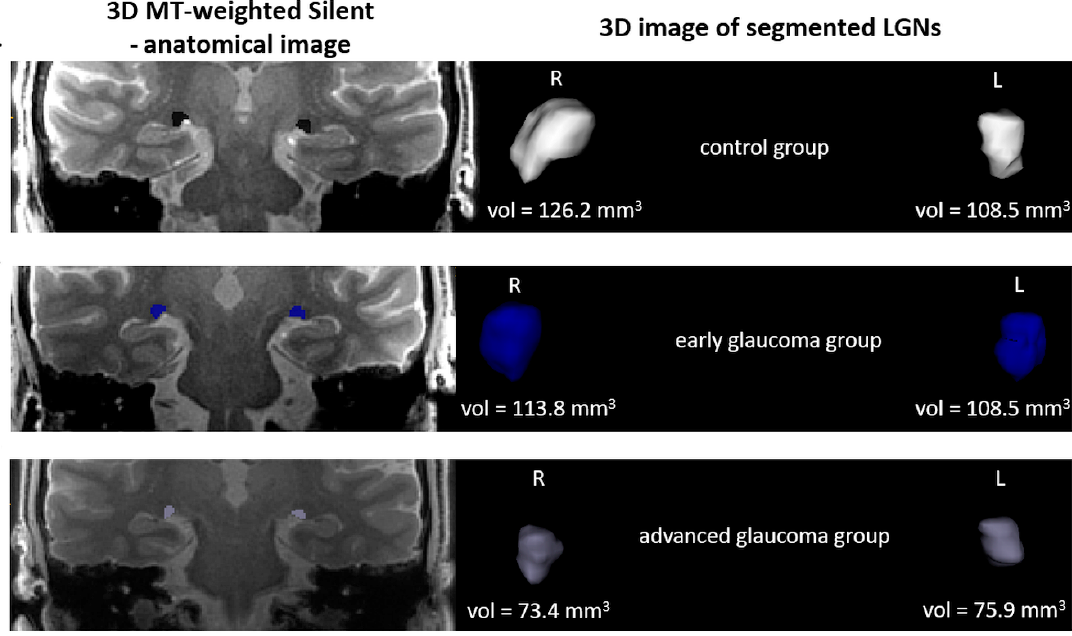
Figure 1. On the left side—3D MT-weighted Silent—the anatomic image of the brain with marked LGNs. Right—results of LGNs manual segmentation. Images show one case chosen from each studied group. ( A ) control group; ( B ) early and ( C ) advanced glaucoma. Images acquired at the Ecotech Complex (Lublin, Poland).